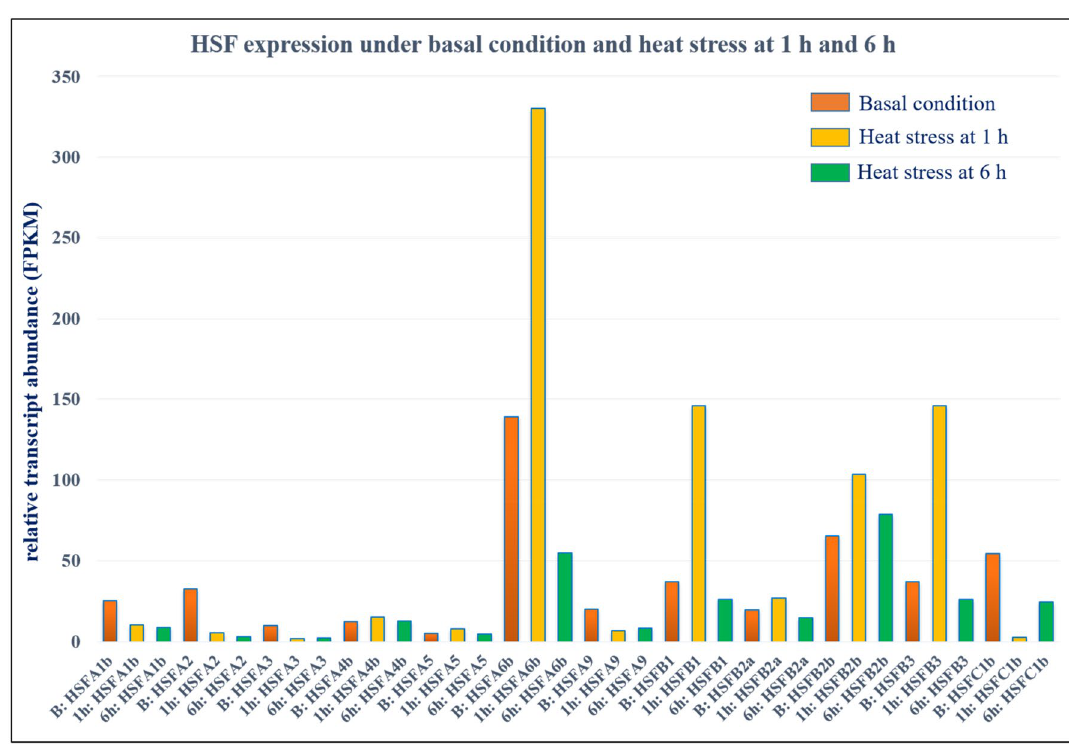
Figure 3. In silico gene expression analysis of 12 HSFs from the transcriptome assemblies in wheat expression database (WheatEXP) represented in the figure as B: basal conditions, 1 h: heat stress at 1 h, and 6 h: heat stress at 6